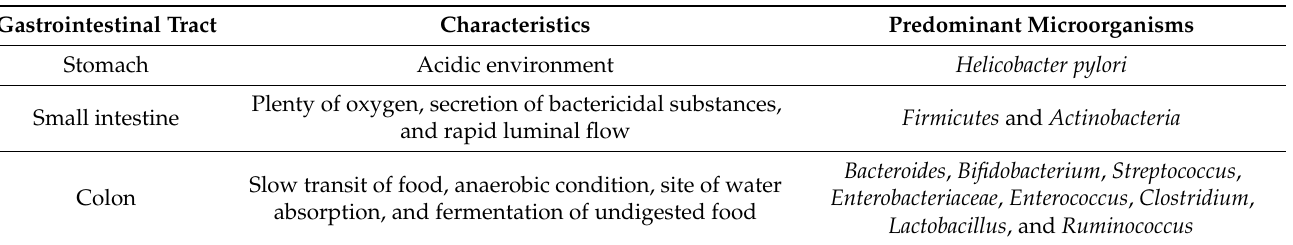
Table 1. Summary of the predominant microorganisms in the various tracts of the digestive system with their basic characteristics.